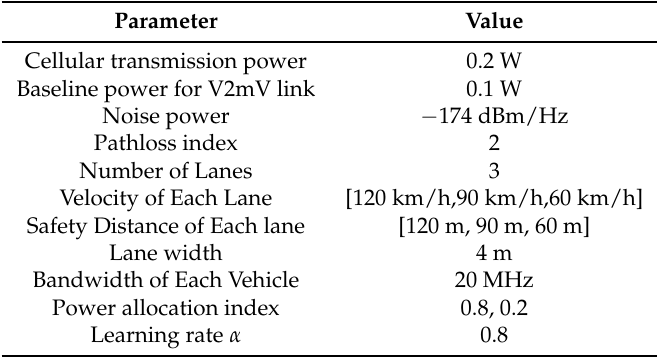
Table 1. System simulation